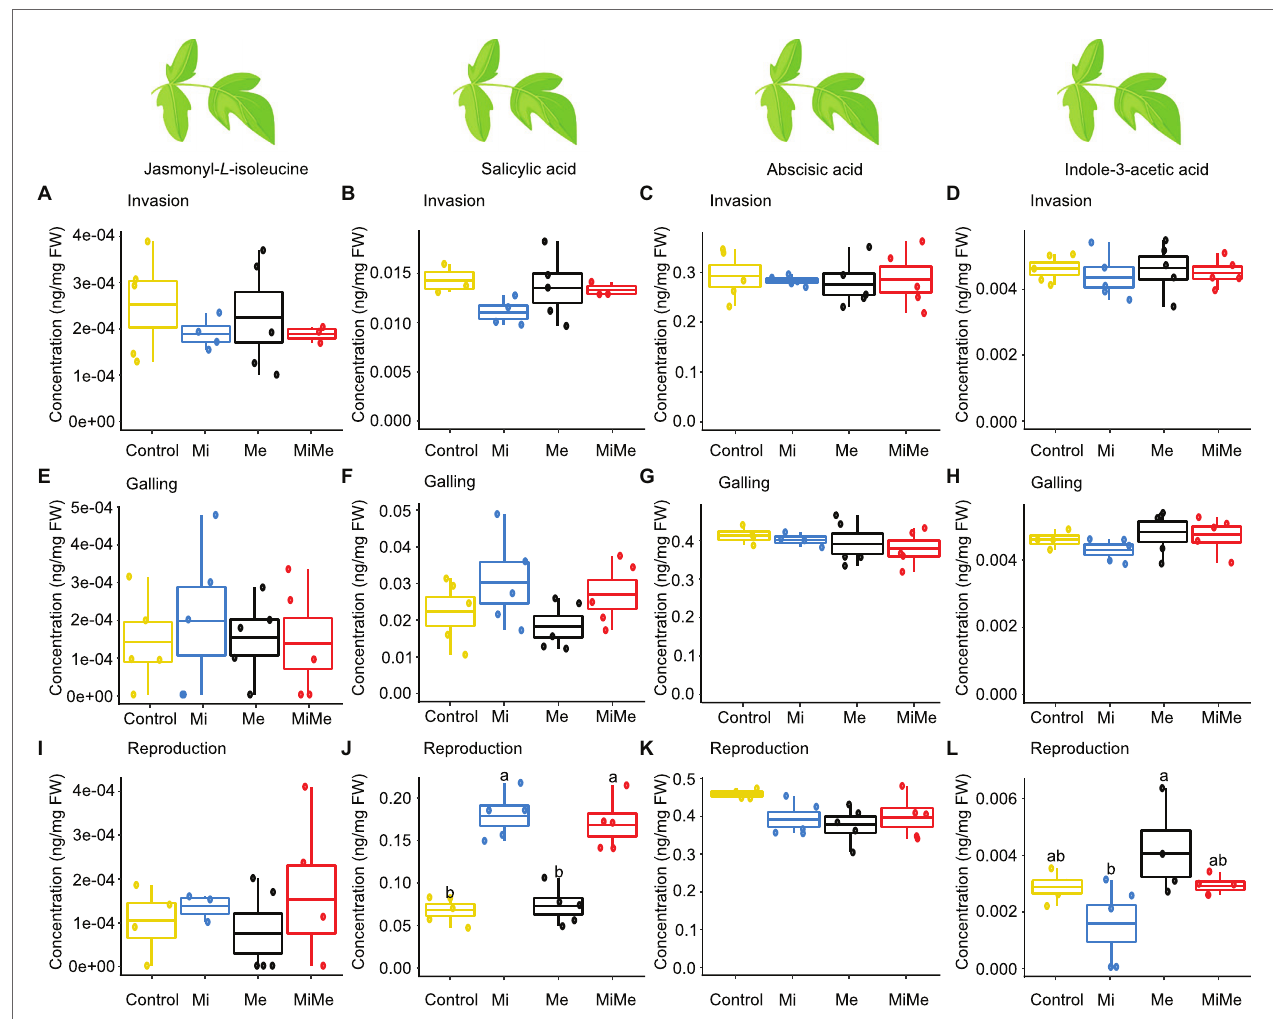
FIGURE 1 | Phytohormones concentrations in tomato leaves upon aboveground and belowground herbivory. Mean concentrations (ng/mg fresh weight) of phytohormones in leaves of tomato plants infected belowground with Meloidogyne incognita (Mi), or infested aboveground with Macrosiphum euphorbiae (Me) or with both herbivores (MiMe). Control = plants without herbivores. Boxplots indicate the mean (±SEM, n = 5) concentrations of jasmonyl- L -isoleucine (A,E,I) , salicylic acid (B,F,J) , abscisic acid (C,G,K), and indole-3-acetic acid (D,H,L) measured at the nematodes’ invasion (A-D) , galling (E-H) , or reproduction (I-L) stages. Different letters above the boxplots indicate significant differences ( p ≤ 0.05) in mean values between treatments, determined by Tukey's HSD test after ANOVA